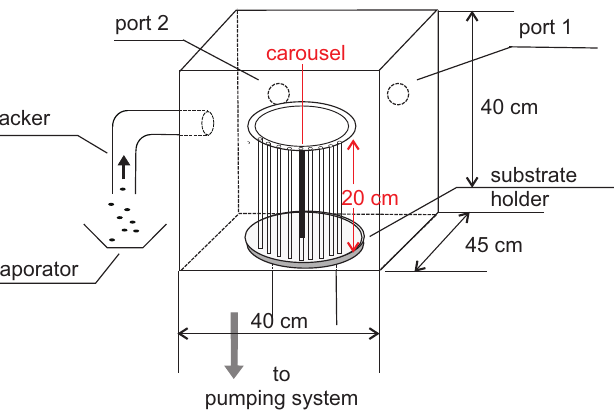
Figure 4. Sketch of the upgraded CVD reactor with carousel for coating of ureteral stents (maximum occupation: 20 stents). The length of the capillaries is 20 cm; they are fixed on a carousel and are vertically aligned.